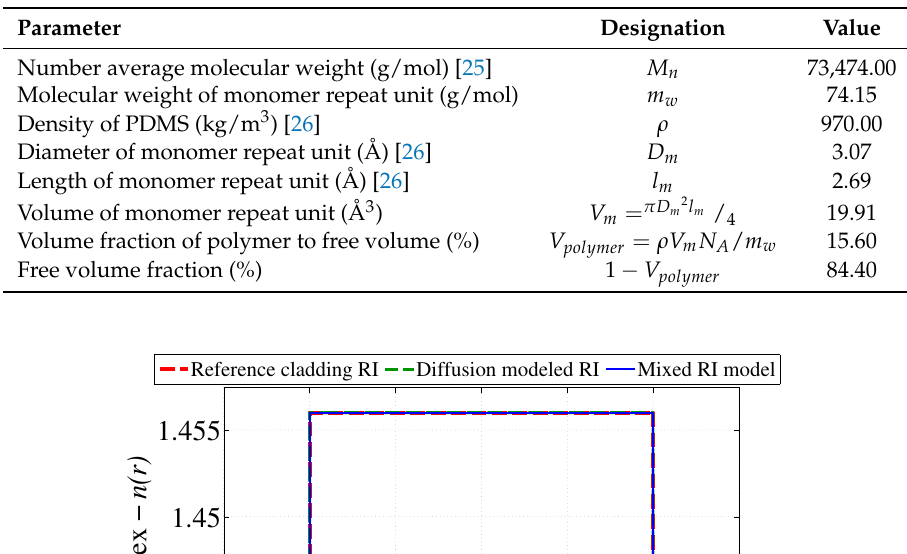
Table 4. Free volume calculation of PDMS polymer utilizing established PDMS properties.